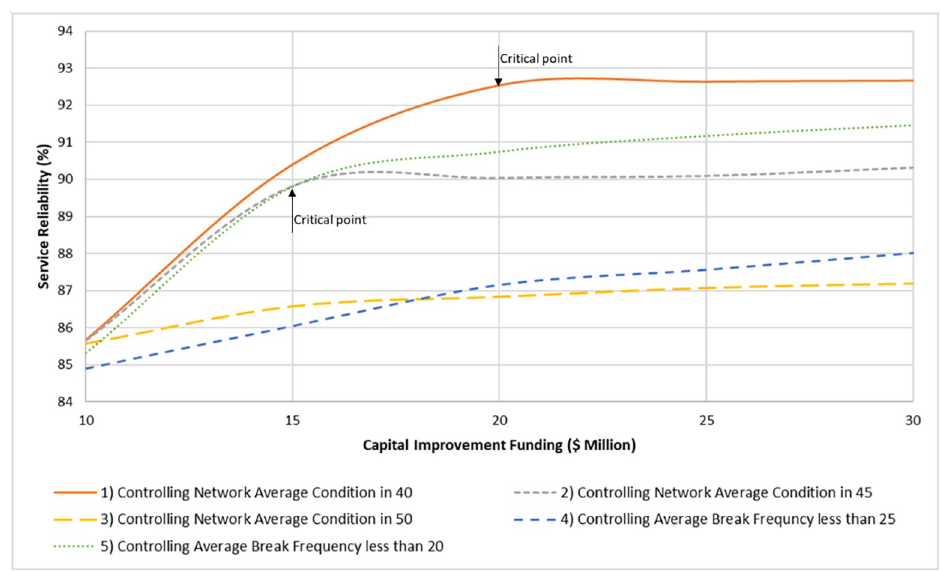
Fig 10. Impact of funding fluctuations on system service